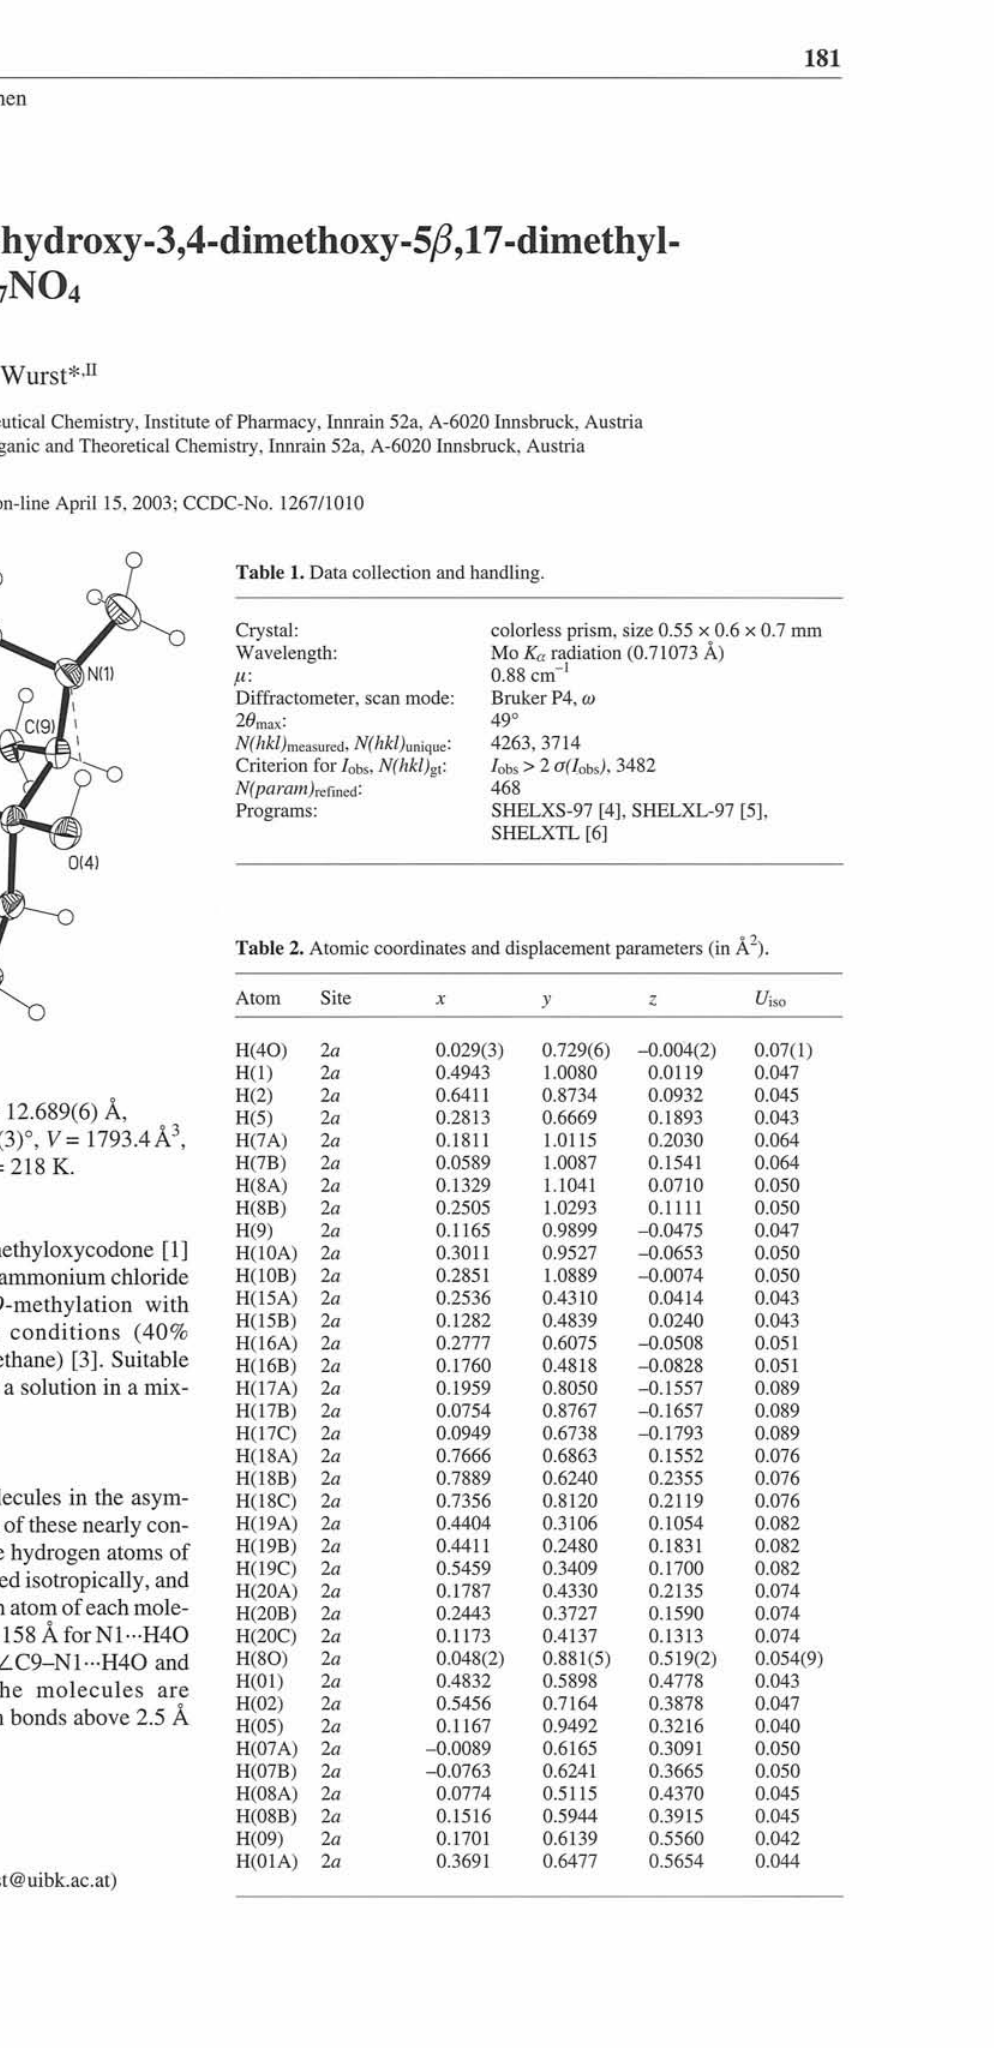
Table 1. Data collection and handling. Crystal: Wavelength: